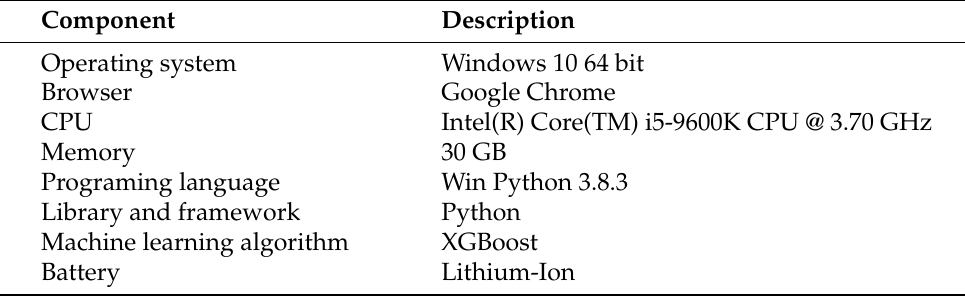
Table 3. System components and